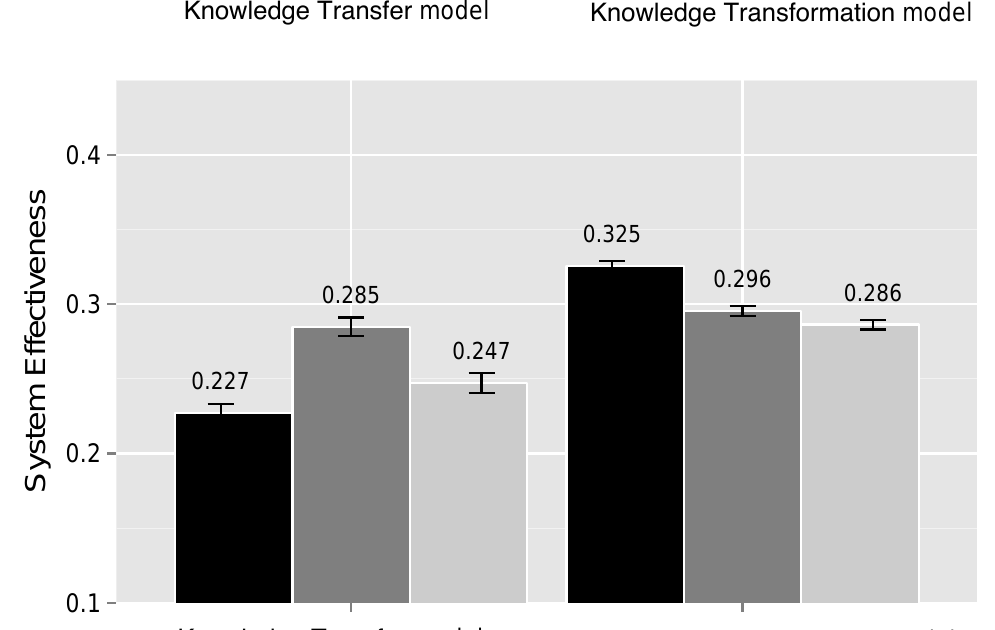
Figure 1: Effects of learning via public repositories, learning via social networks, and mixed information on system efficiency and effectiveness (the knowledge transfer model versus the knowledge transformation model). Maximum efficiency and effectiveness in both models are normalized to 1. Results are based on 50 simulated agents solving 2 problems (100 times each) with 13 unique network